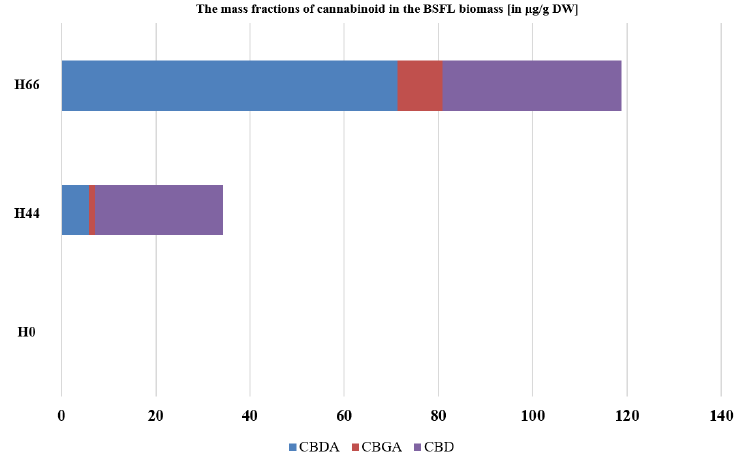
Figure 4. The mass fraction of cannabinoids in dry black soldier fly larvae (BSFL). BSFL were grown on substrates with 0% hemp (H0), 44% hemp (H44), or 66% hemp (H66). Shown is the mean cannabinoid mass fraction. The Student’s t test (n = 5, p < 0.05) revealed significant differences in the mass fraction of cannabidiolic acid (CBDA), cannabigerolic acid (CBGA), and cannabidiol (CBD). Only traces of CBC, CBCA, ∆ 9 -THC, and THCA were detected in some samples.